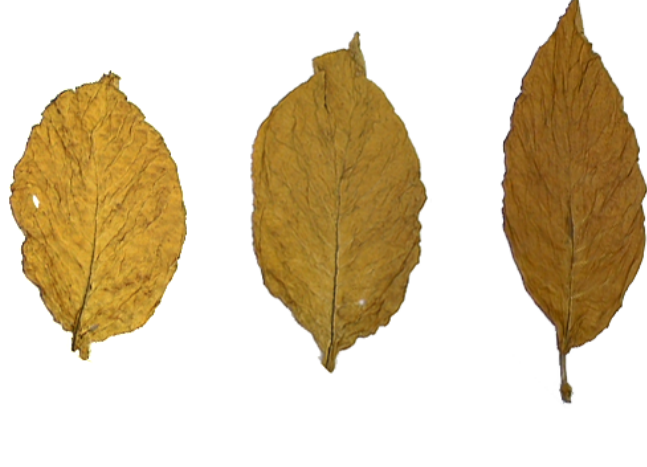
Figure 1. Three images of tobacco leaves which are obtained from image processing system of tobacco leaves